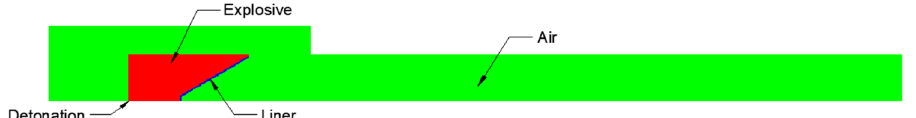
Figure 5. 2D axial symmetry numerical model.